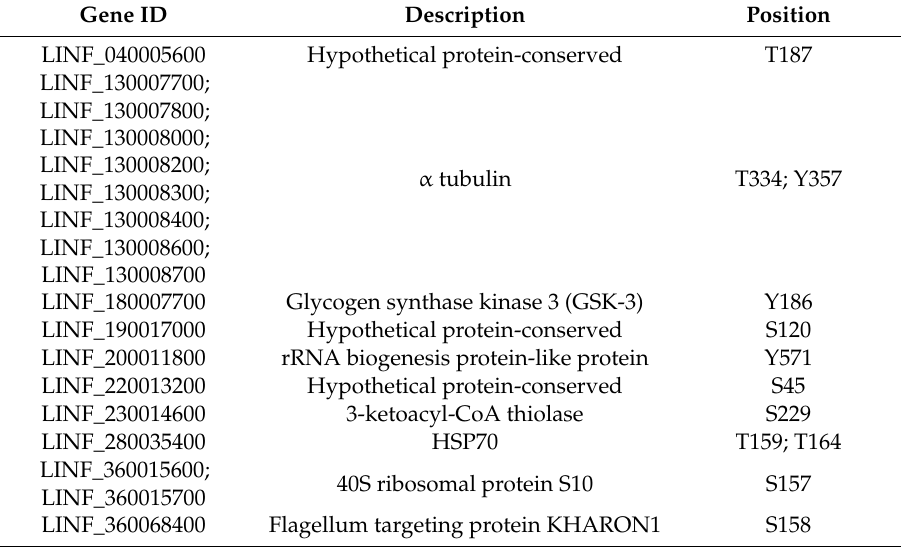
Table 6. Phosphoproteins in the L. infantum